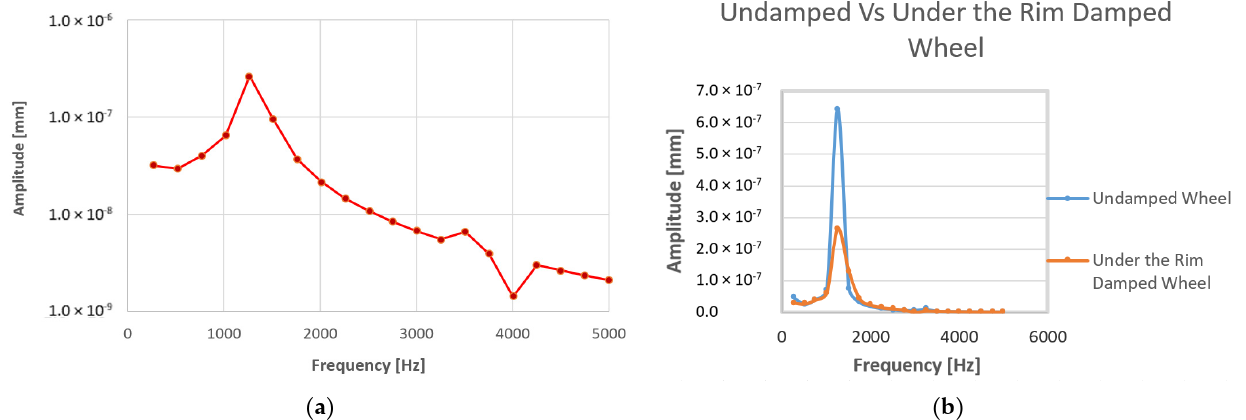
Figure 15. Harmonic response analysis in the radial direction with viscoelastic damping layer on both sides under the rim. ( a ) Radial harmonic excitation of the wheel mounted with viscoelastic layer under the rim on both sides of the wheel. ( b ) Comparison between the undamped and damped wheels when radially excited.